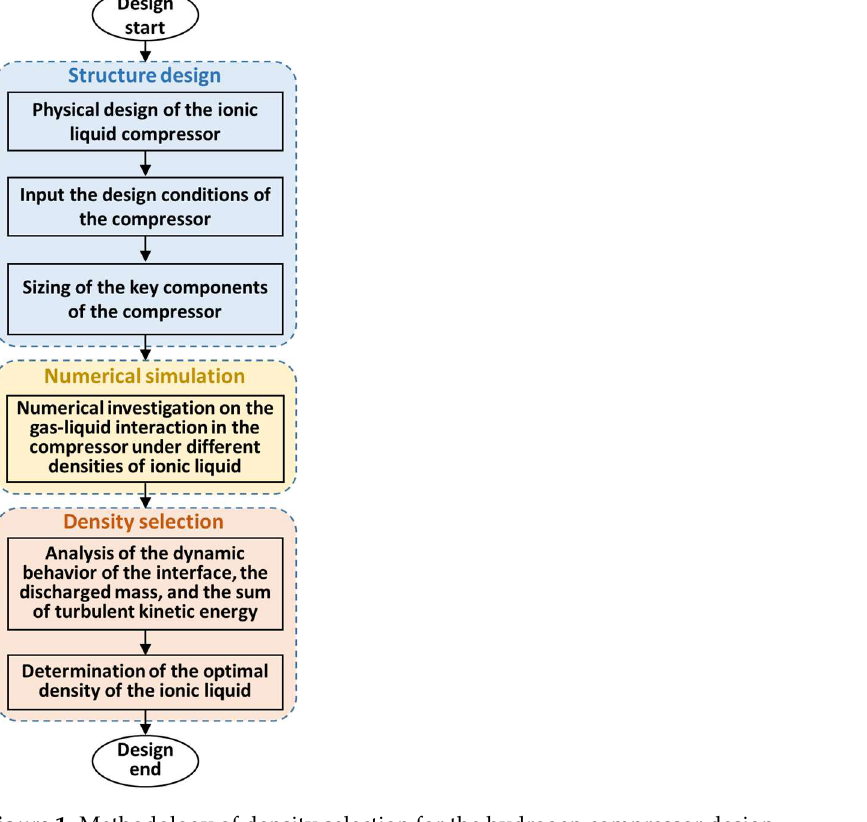
Figure 2. Physical structure of hydrogen compressor. After the physical design is finished, the sizes of the major components of the gas compression part are determined according to the design requirements. The requirements